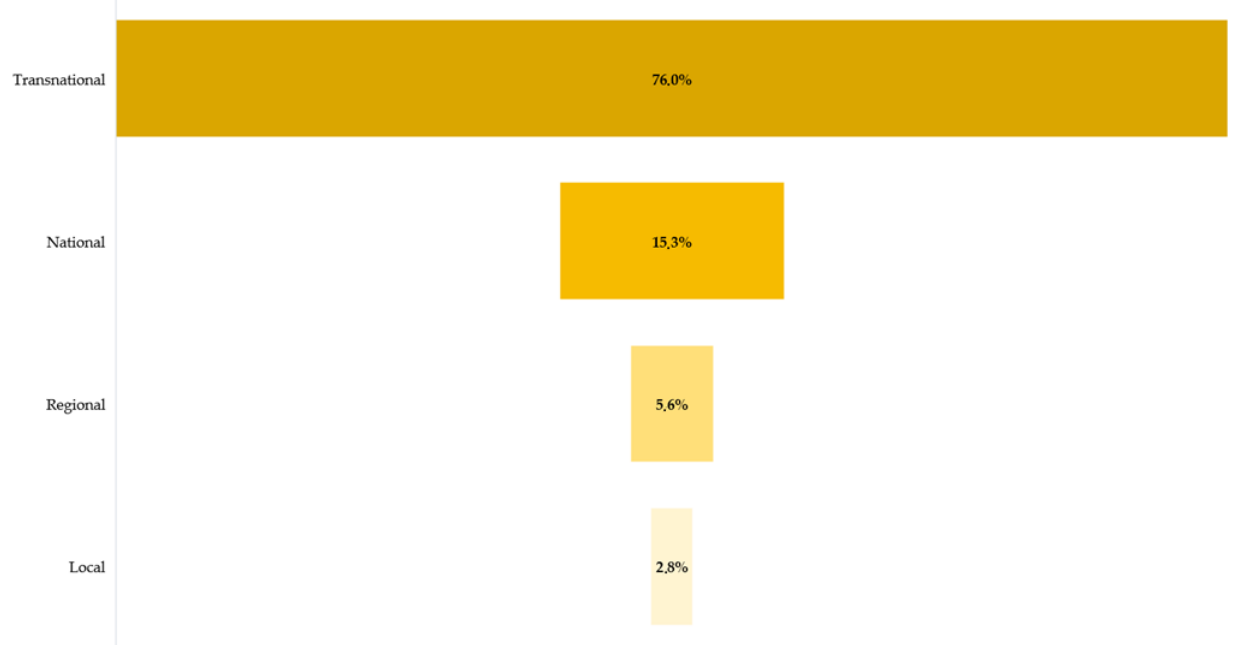
Figure 5. Data file structure by territorial location of enterprises . Source: Author's own.